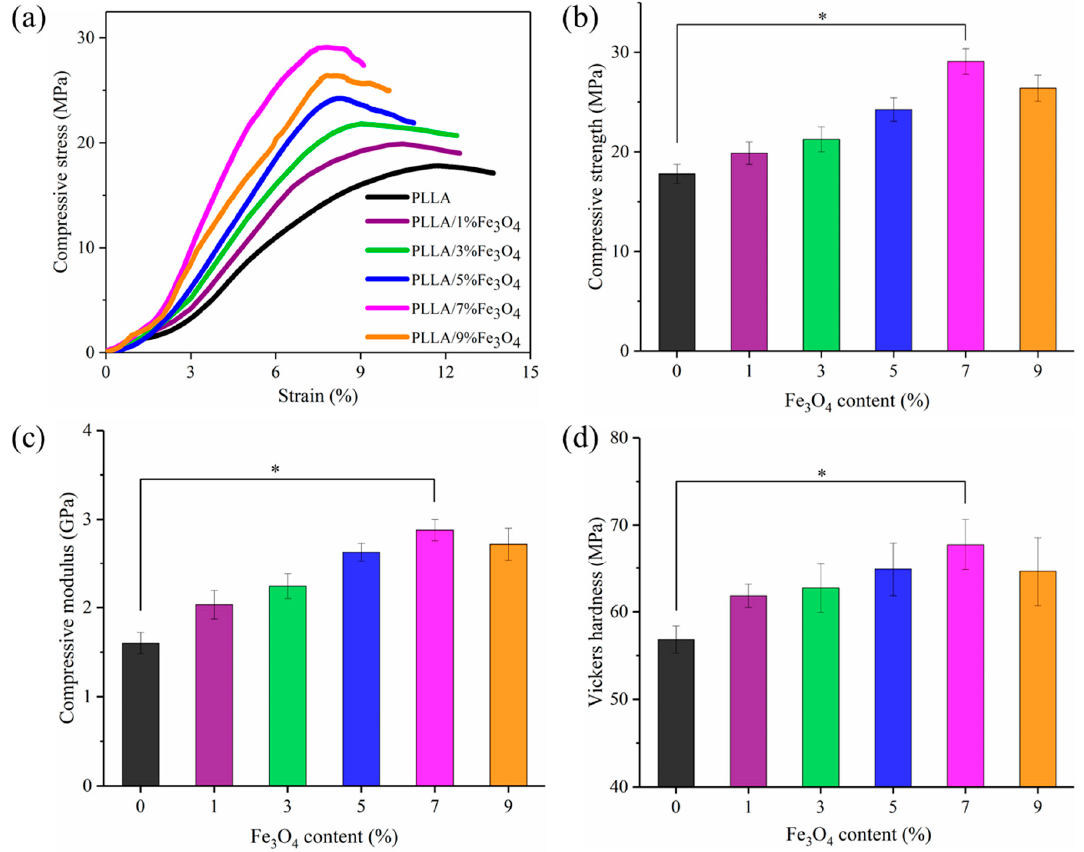
Figure 4. Mechanical properties of the scaffolds. ( a ) Stress-strain curve ( b ) Compressive strength ( c ) Compression modulus ( d ) Vickers hardness. *Represented significant difference ( p < 0.05) when the PLLA/7%Fe 3 O 4 scaffold compared with the pure PLLA scaffold.